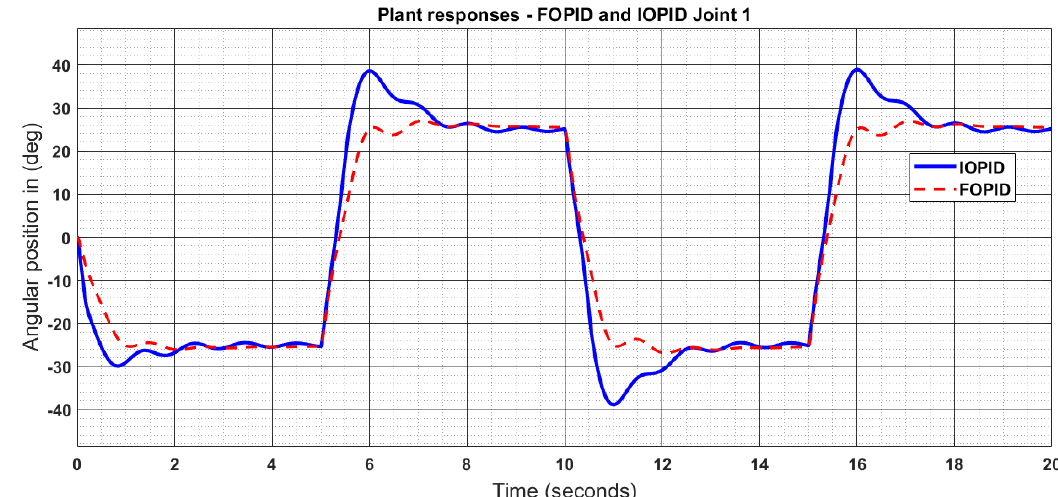
Figure 8. Controller responses for angular shift ( φ ) for Link 1.